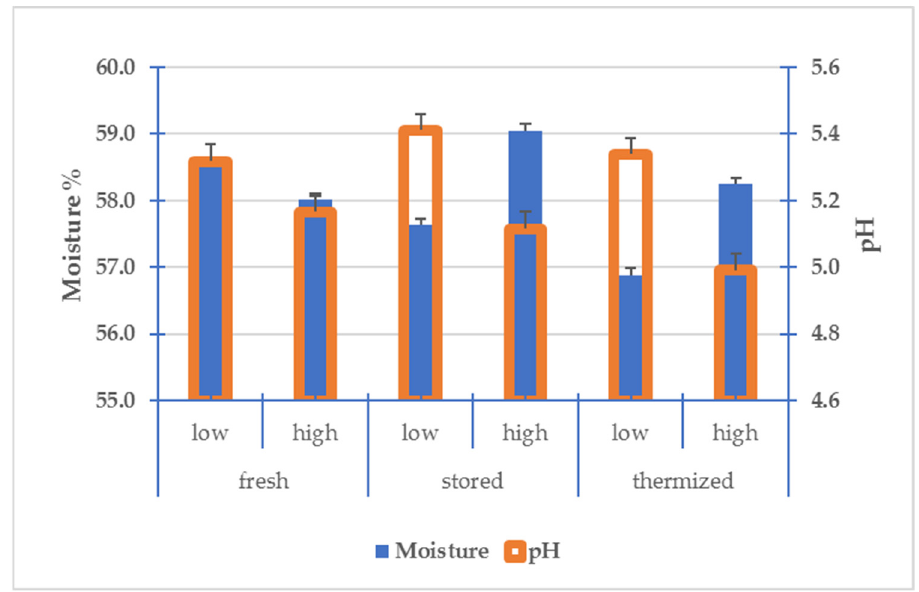
Figure 3. pH values and moisture content in cheese produced using fresh (F), stored (S), and thermized (T) milk subjected to low (L) or high (H) pasteurization.